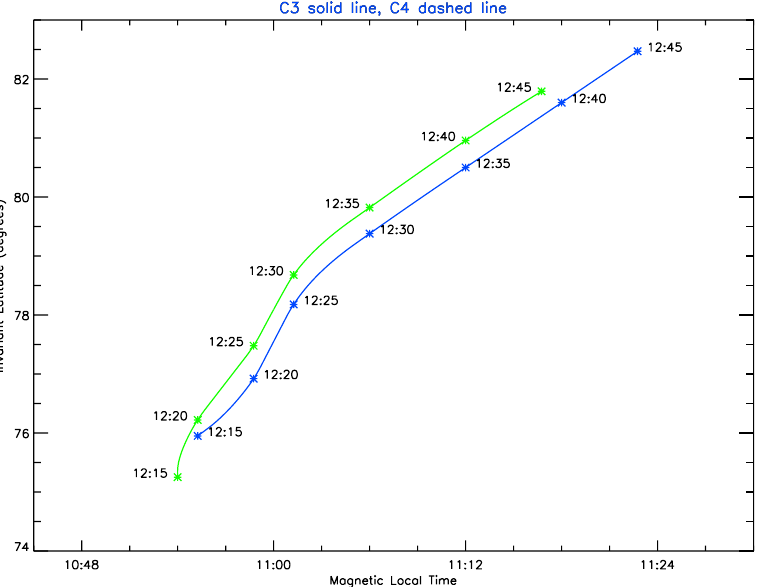
Fig. 1. Spacecraft orbits plotted in MLT against invariant latitude for the interval 12:15 to 12:45UT; Cluster 3 is the blue line and Cluster 4 is the green